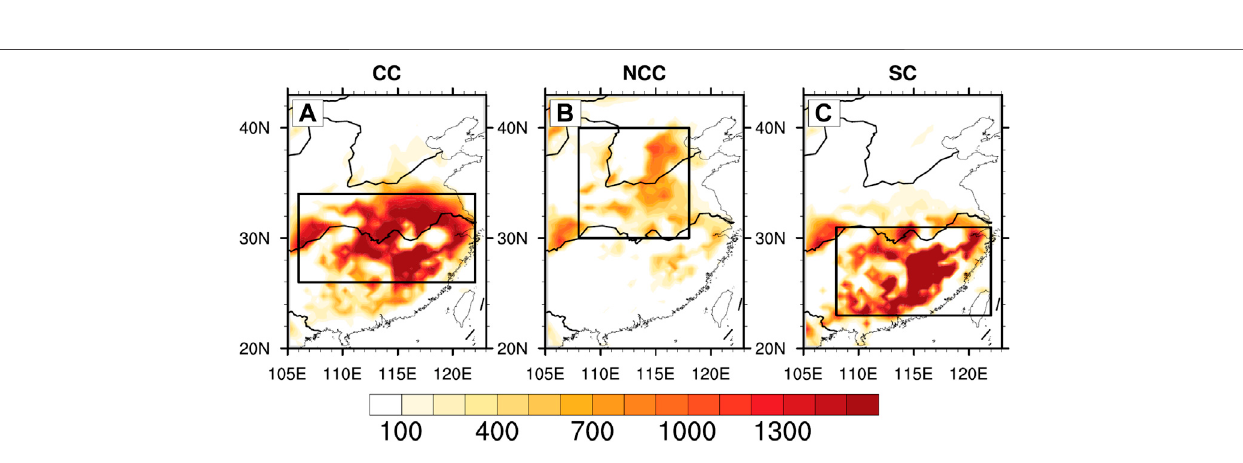
FIGURE1| SpatialdistributionsofHWF(shaded,unit:pentadperyear)andHWCG(bluedot)forclusterregionsinCC (A) ,NCC (B) ,andSC (C) overeasternChina. The black boxes indicate the speci fi c cluster regions.